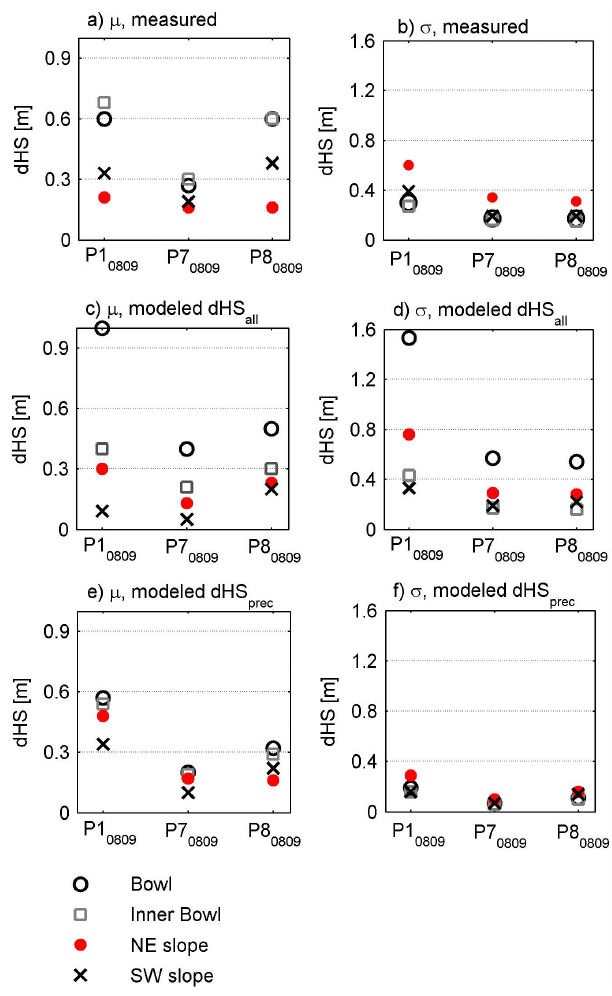
Fig. 13. Mean values (a, c, e) and standard deviation (b, d, f) for measured and modeled dHS for four sub-areas. Modeled dHS were derived from simulations where all wind-induced snow-transport processes (dHS all ) were calculated (c, d) , and where only the pref- erential deposition of precipitation (dHS prec ) was simulated (e, f)